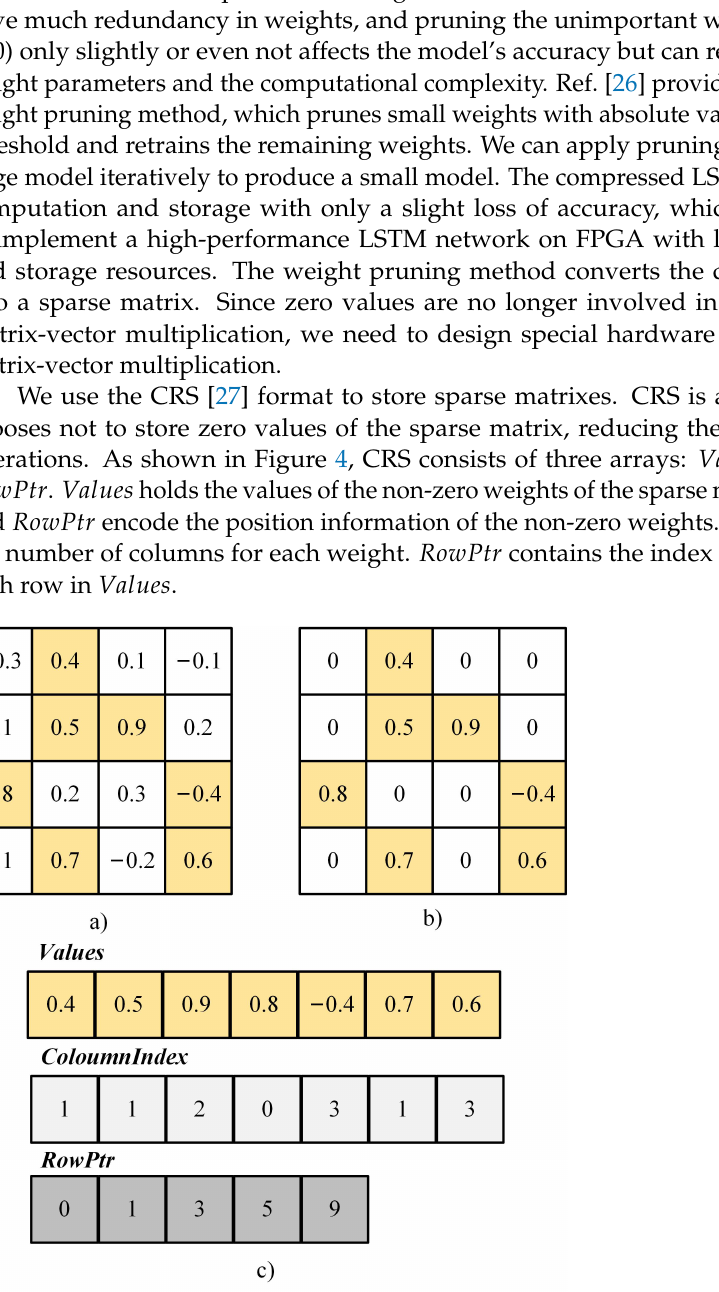
Figure 4. ( a ) dense matrix before pruning; ( b ) sparse matrix after pruning (threshold set to 0.4); ( c ) sparse matrix of CRS